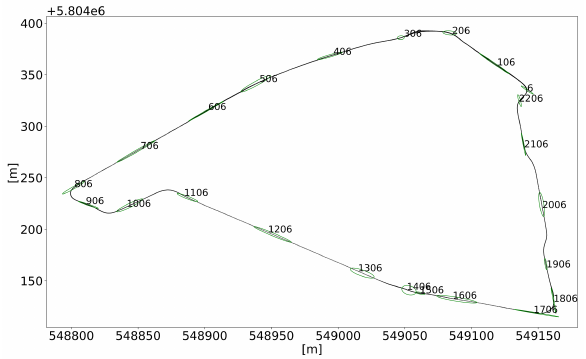
Figure 17. Trajectory of the measurement along with the covariance ellipses of every 100th epoch (ellipses enlarged by a factor of 100).